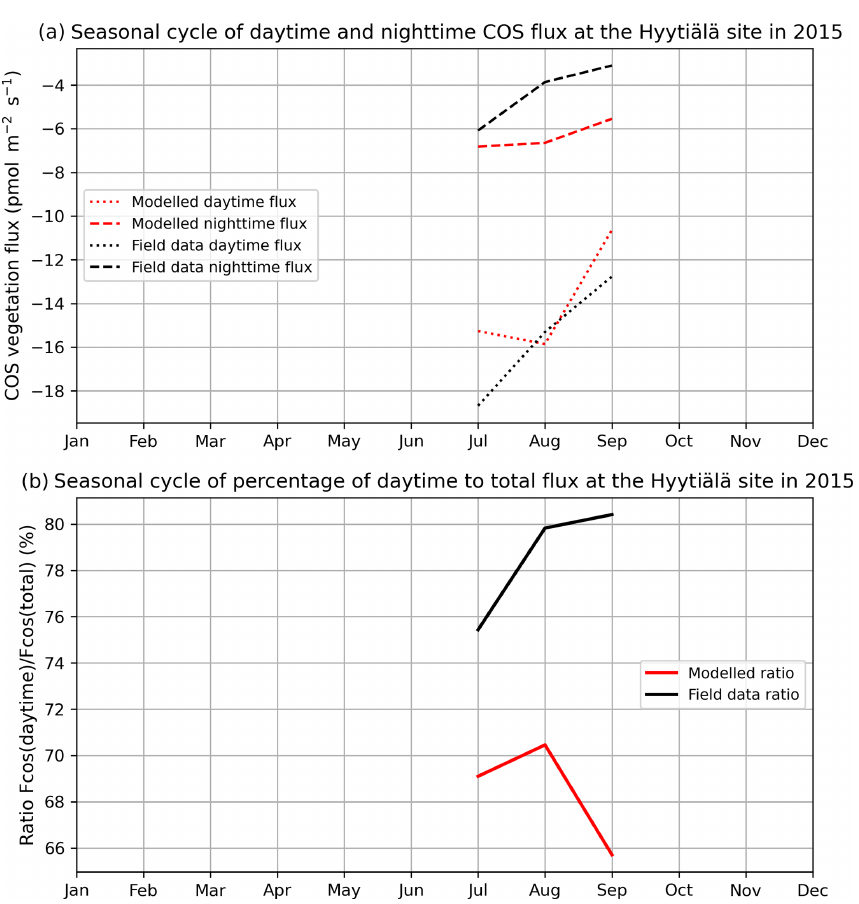
Figure B2. (a) Seasonal cycle of daytime (dotted curve) and nighttime (dashed curve) for observed (black) and modelled (red) vegetation COS fluxes. (b) Seasonal cycle of percentage of the daytime to the total flux (solid curve), at the Hyytiälä site in 2015.